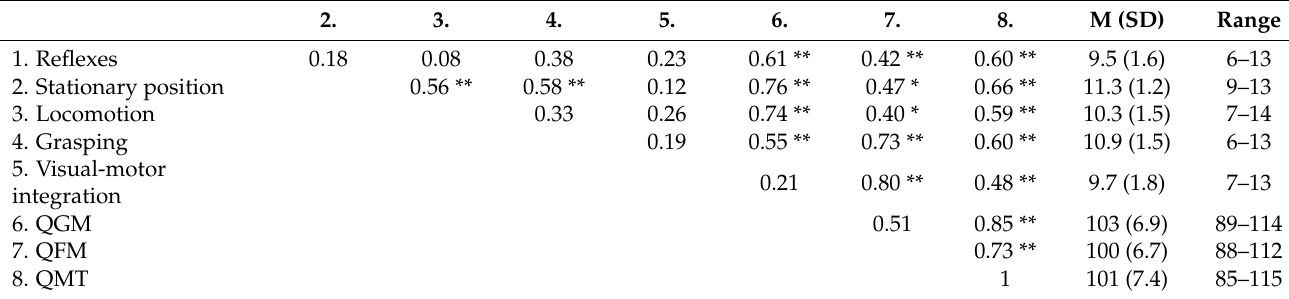
Table 1. Descriptive statistics and correlations among